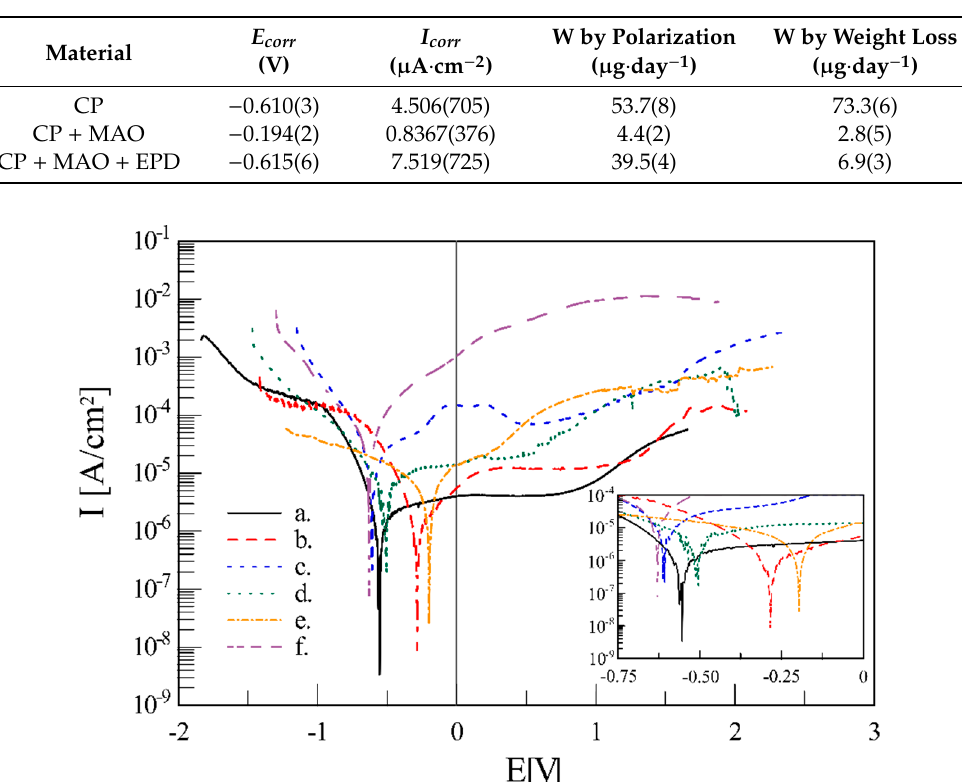
Figure 8. Potentiodynamic test result curves of Ti23Mo alloys obtained by different processing approaches in Ringer solution: Arc melted and annealed at 800 °C/24 h ( a ), MA for 48 h and hot pressed at 800 °C/5 min ( b ), cold-pressed and sintered at 800 °C/0.5 h ( c ), cold-pressed with NH 4 HCO 3 and sintered at 1150 °C/10 h ( d ) and cold-pressed and sintered at 800 °C/0.5 h after surface treatment: MAO ( e ), MAO and EPD ( f ).